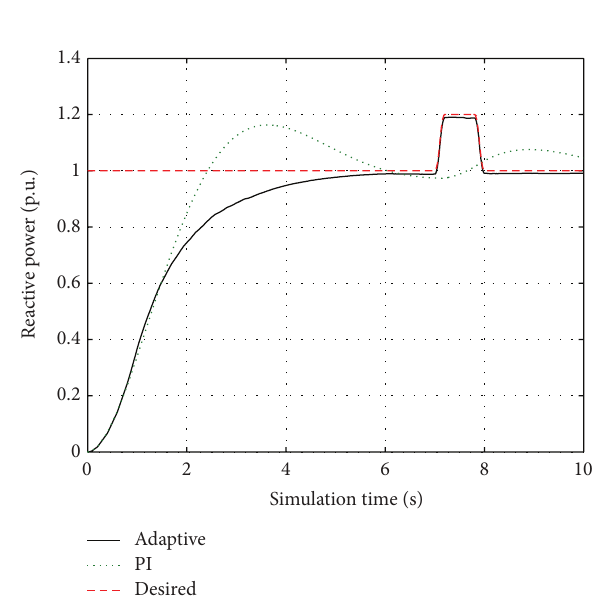
Figure 7: Reactive power tracking